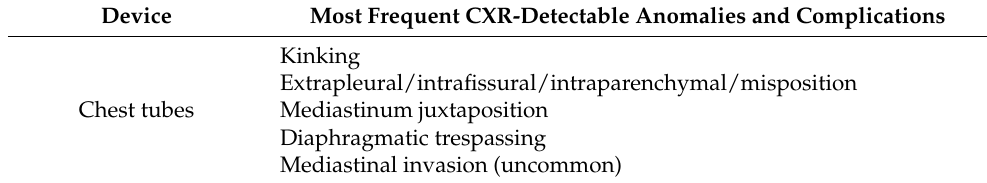
Table 6. Chest tubes’ most frequent CXR-detectable anomalies and complications.